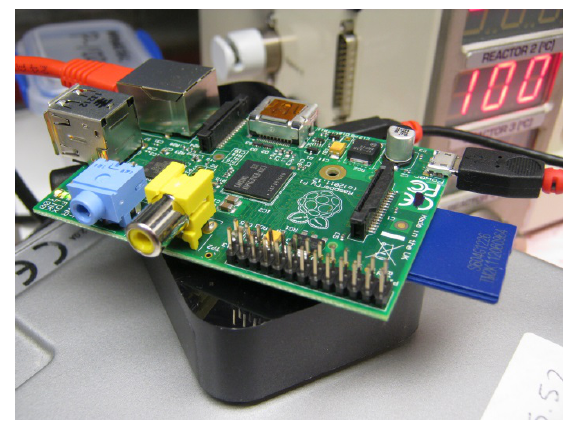
Figure 1: Raspberry Pi ® (RPi) computer operating in the laboratory, shown here without its protective case. Underneath is a USB hub (D-Link DUB-H7) which supplies power to the RPi via a short USB cable. The RPi is controlled remotely through the Ethernet connection (red cable) so no monitor, keyboard or mouse is required which reduces the space taken up inside the fume hood. In this case the RPi also communicates with the instruments via the Ethernet connection (the Vapourtec unit pictured in the background is connected using a Brainboxes ES-257 Ethernet-serial converter). Alternatively, a USB- serial connector (such as Lindy P/N 42689) can be plugged directly into the RPi or through the USB hub for serial